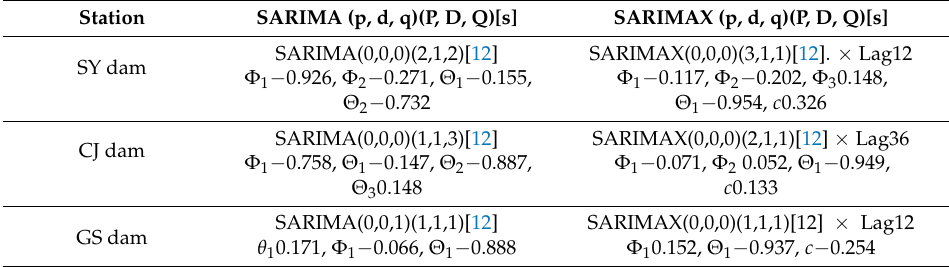
Table 5. Parameters of best SARIMA and SARIMAX models for the SY, CJ, and GS